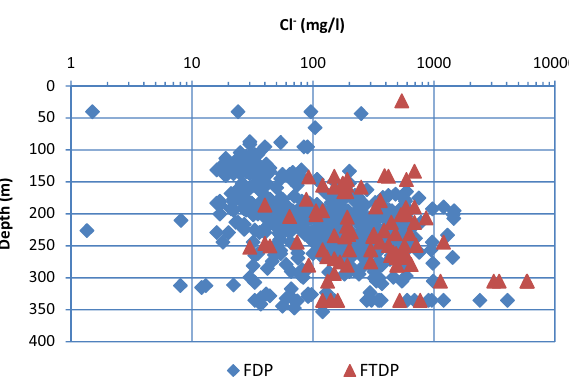
Fig. 7 Depth distribution of chloride concentrations in groundwater of the study